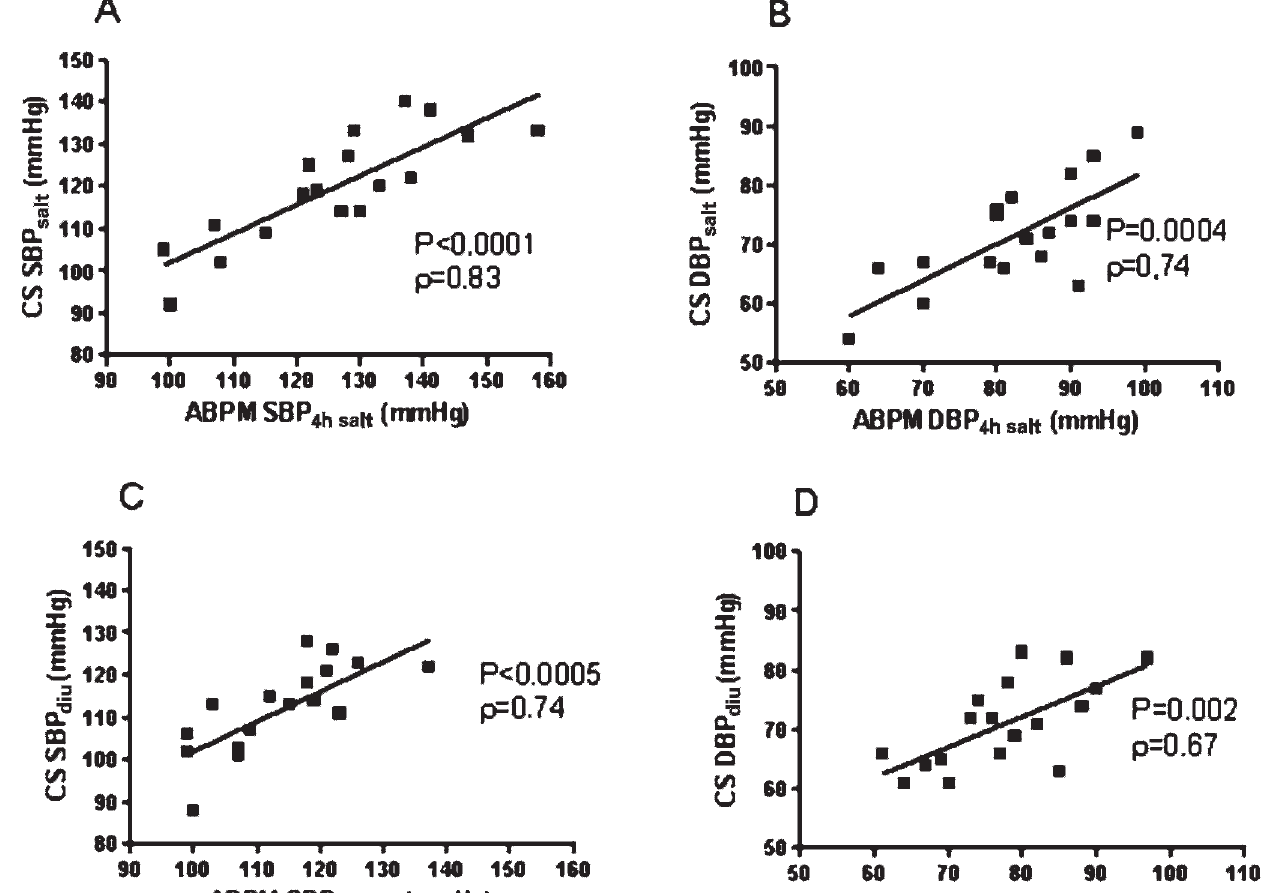
Figure 2 - Pearson correlation coefficients ( r ) between CS SBP and DBP, with mean BP measured by ABPM during the phase of salt loading (4 h, upper panel A and B) and of salt depletion with furosemide (12 h, lower panels C and